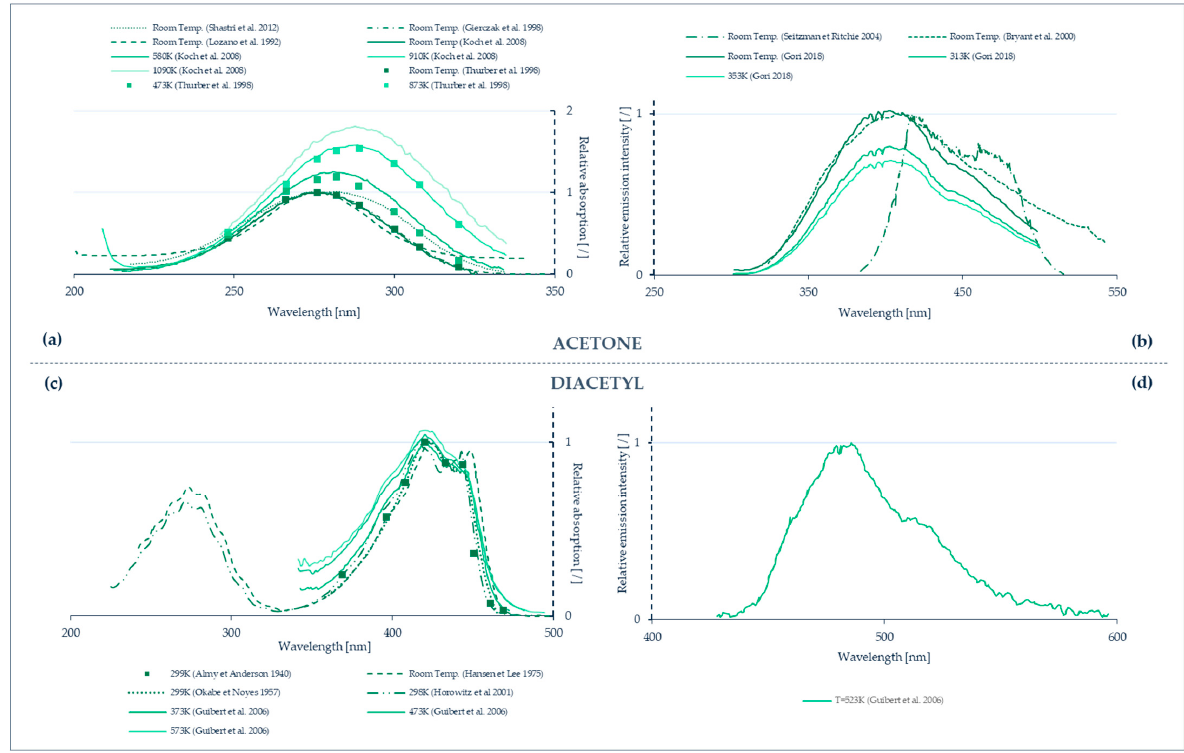
Figure 32. ( a ) Absorption spectra of acetone at different temperatures, from Thurber et al. [173]; ( b ) Fluorescence emission spectra of acetone, from Tran et al. [174]; ( c ) Absorption spectra of diacetyl, from Stier et al. [176]. ( d ) Fluorescence emission spectra of diacetyl, from McKenzie et al. [177]. All the measurements obtained at room temperature have been normalized by their peak value.